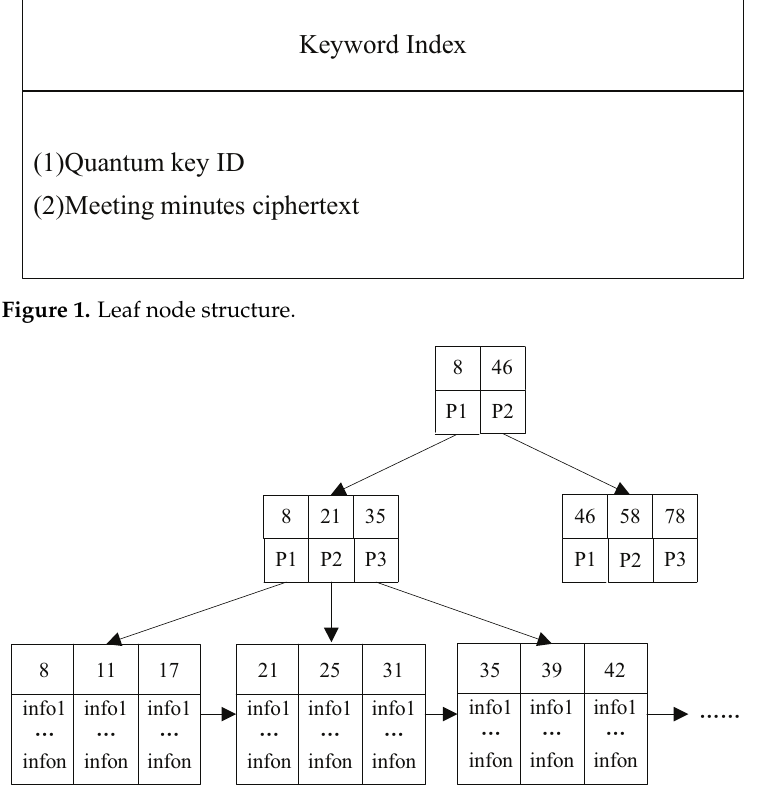
Figure 2. B+ tree